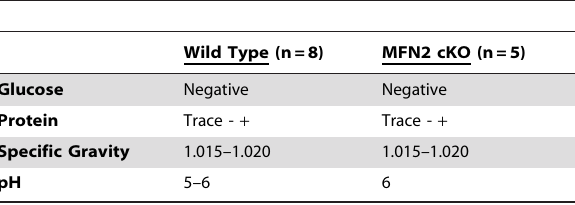
Table 1. Effect of MFN2 conditional knockout on tubular function in four day old